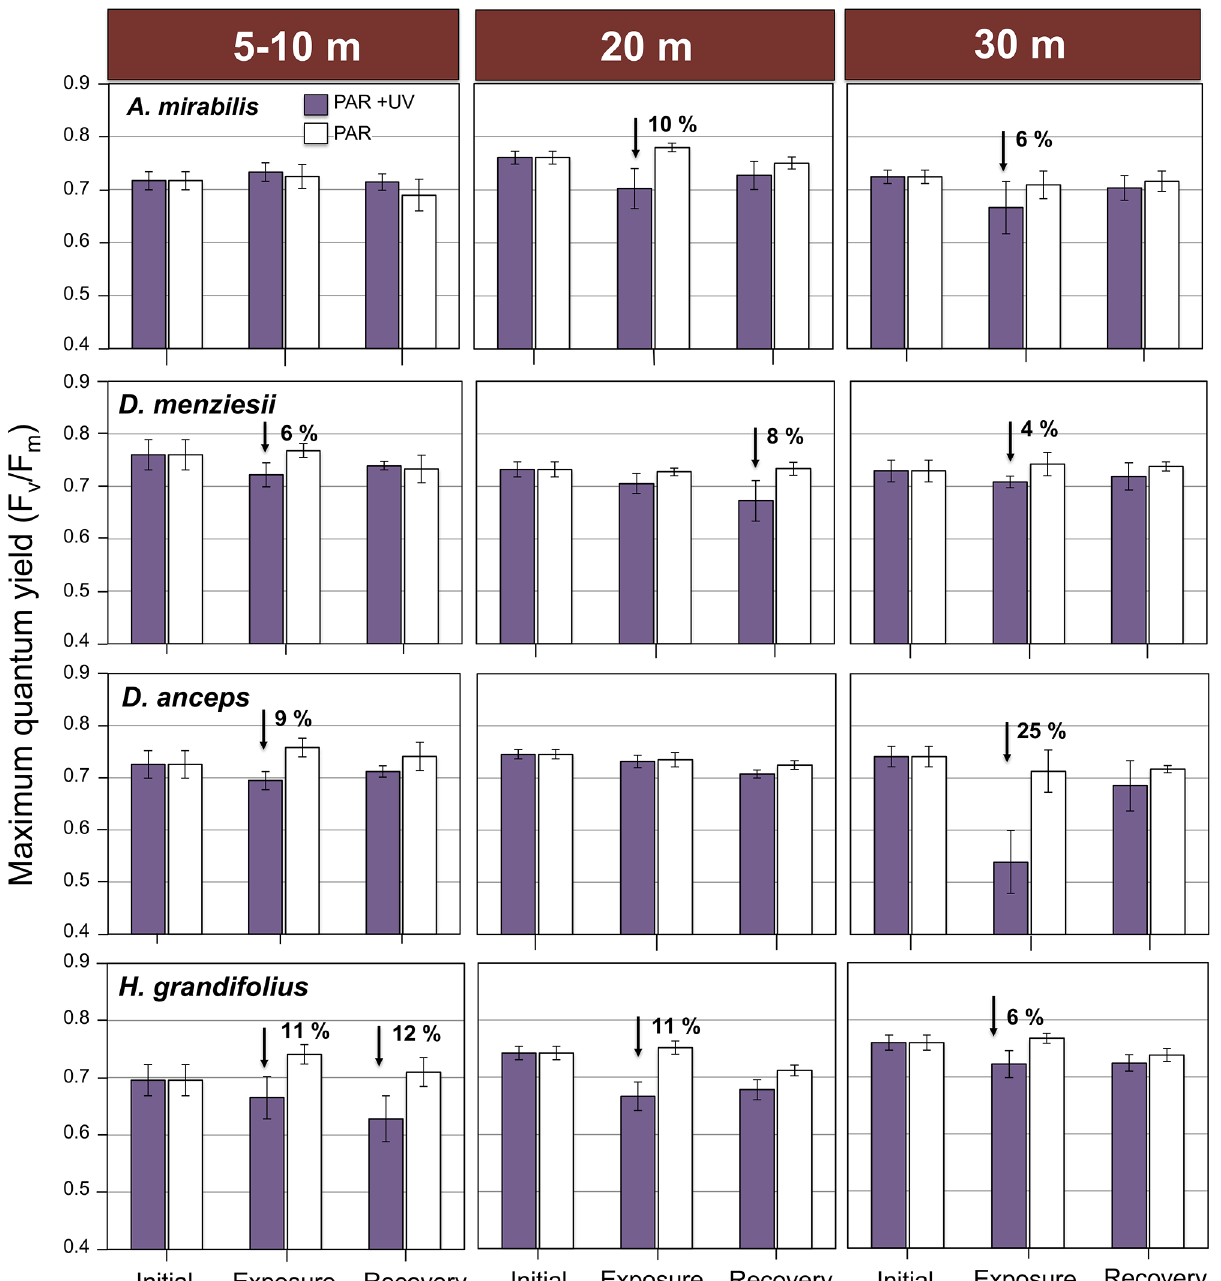
Fig 5. Effect of UV radiation on the maximal quantum yield of fluorescence (F v ⁄ F m ) of four Antarctic algae collected to different depths. Algae were exposed for 6 h to PAR+UV-A+UV-B (PAR + UV) and PAR conditions (20 μ mol m -2 s -1 for PAR, 3 W m -2 for UV-A and 0.25 W m -2 ), and returned to control culture conditions under dim PAR for 12 h (recovery). Initial is the time cero before the 6 h exposure to UV radiation. Values are means ± S.D., n = 9. The significant decrease in photosynthesis in the UV treatment relative to PAR (ANOVA and Tukey HSD post hoc test) is indicated.